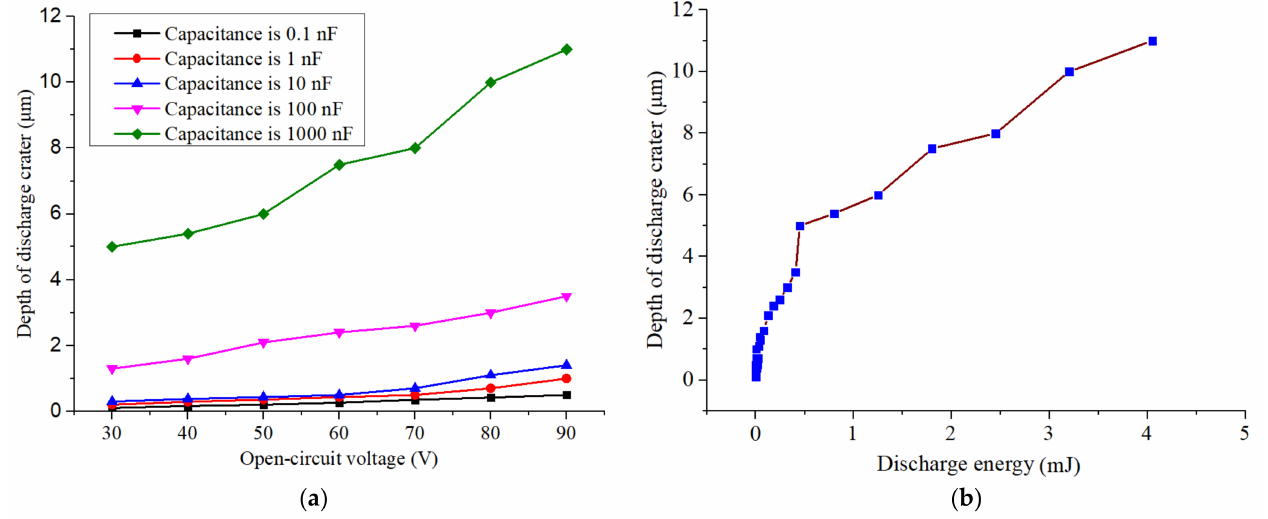
Figure 5. Effect of open-circuit voltage ( a ) and discharge energy ( b ) on the depth of the discharge